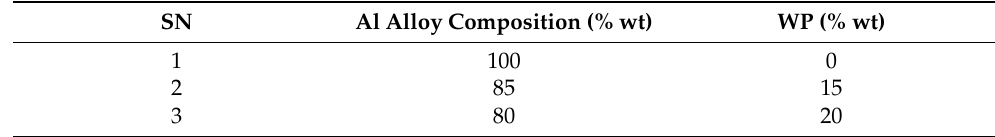
Figure 2. Composite production route. Table 3. Alloy matrix